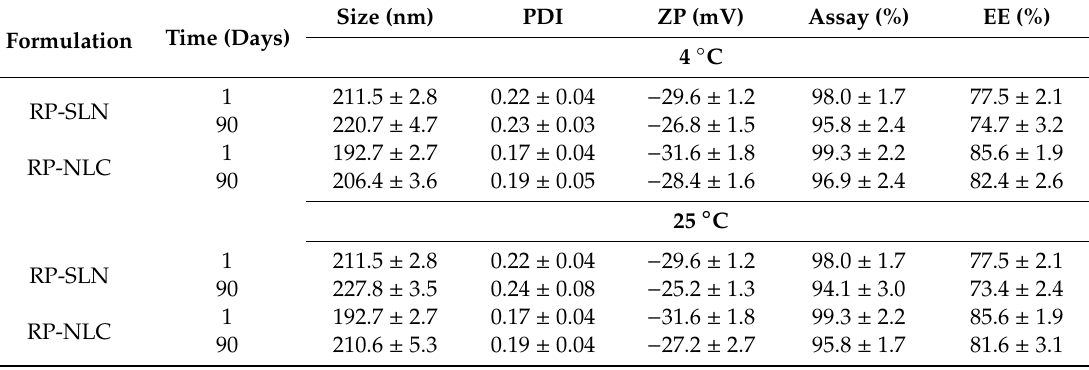
Table 6. E ff ect of storage conditions on particle size, PDI, ZP, assay, and entrapment e ffi ciency